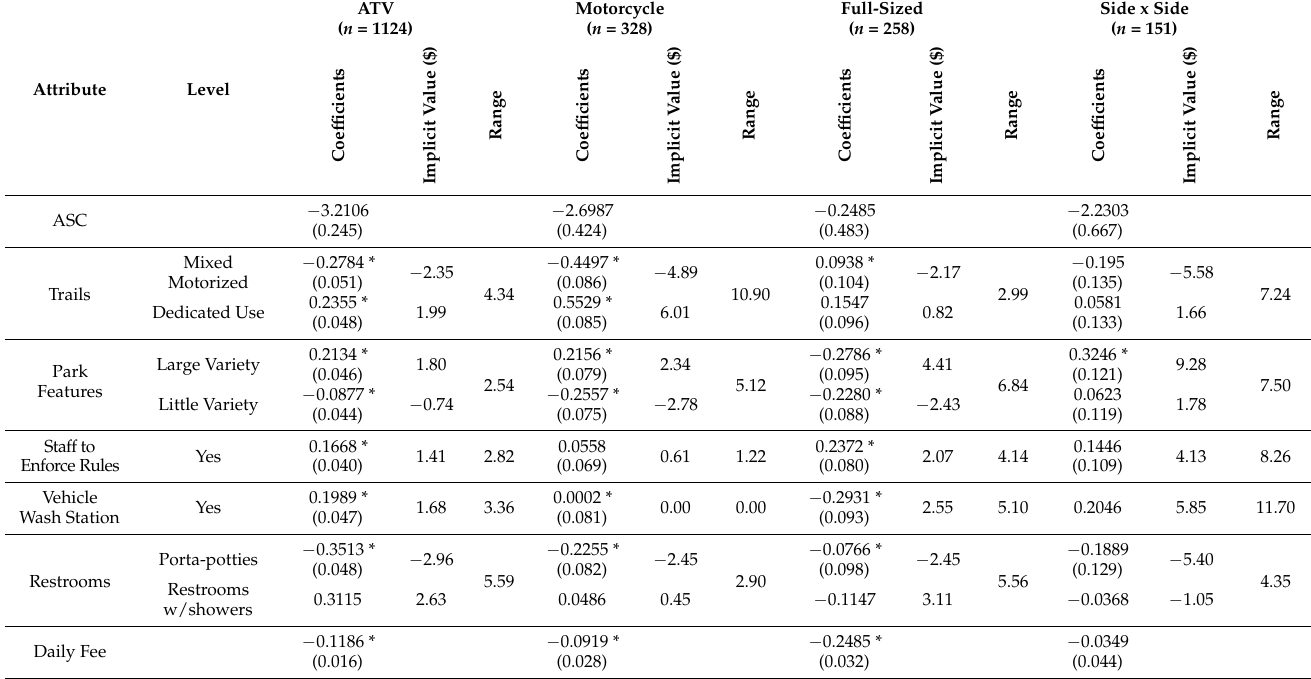
Table 3. Summary of choice model findings by vehicle